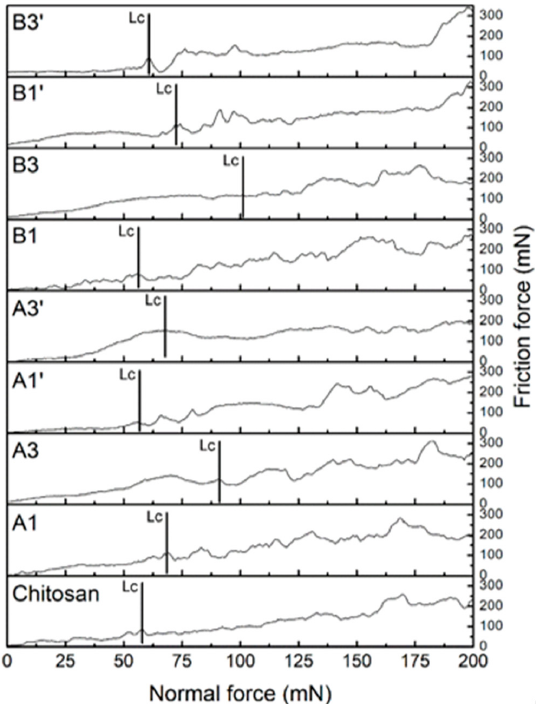
Figure 6. The dependence of the friction force on the normal force obtained for chitosan and chitosan/Eudragit E100 coatings with an indication of the critical force causing complete delamination of the coating from the titanium substrate. Table 4. Nanoscratch test properties of the chitosan and chitosan/Eudragit E 100 coatings (mean ± SD; n = 10).